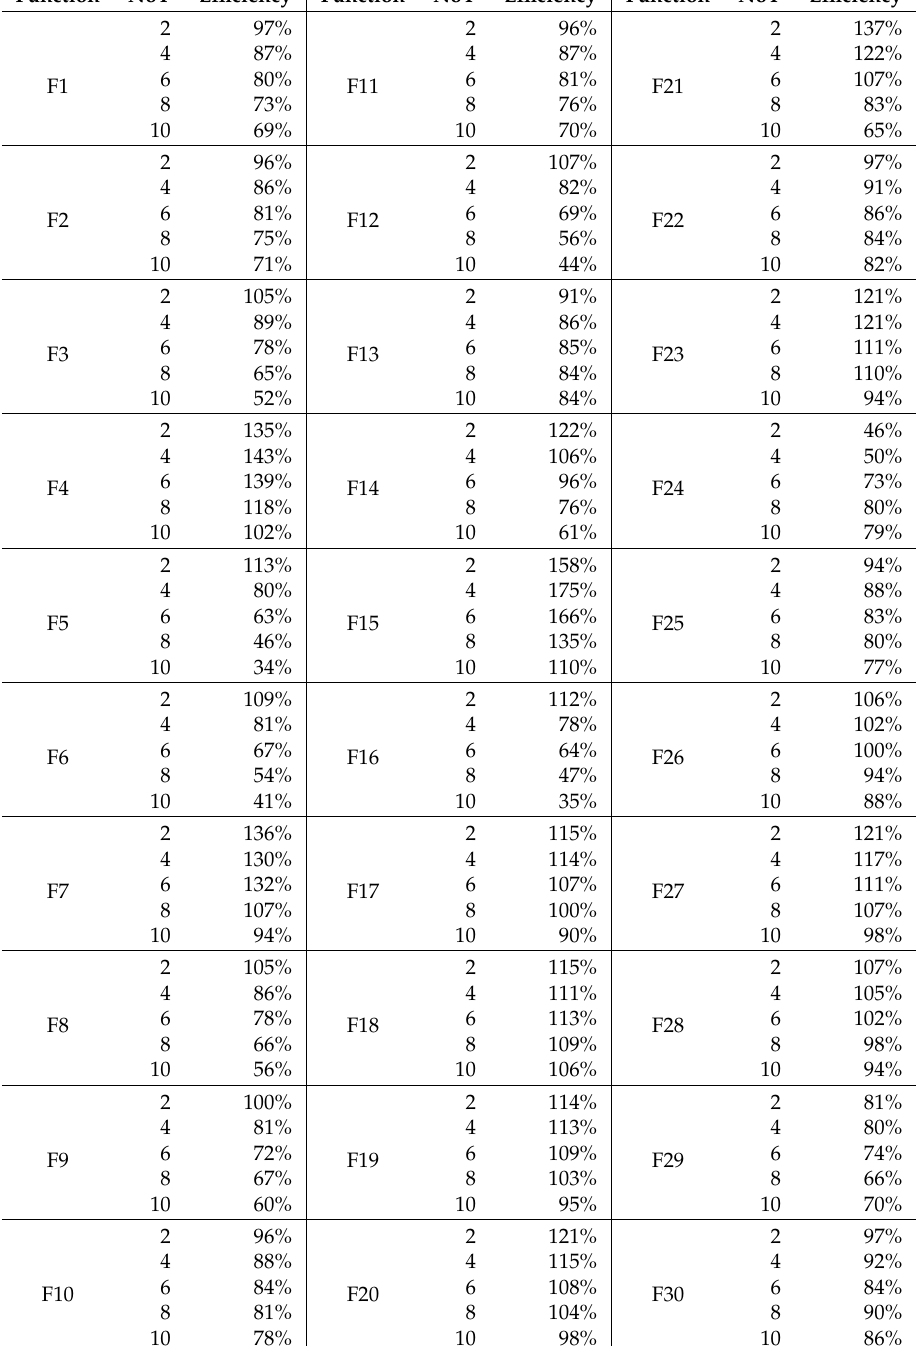
Table 7. Efficiencies for SPP_TLBO, Runs = 30, Population size = 120, Iterations =